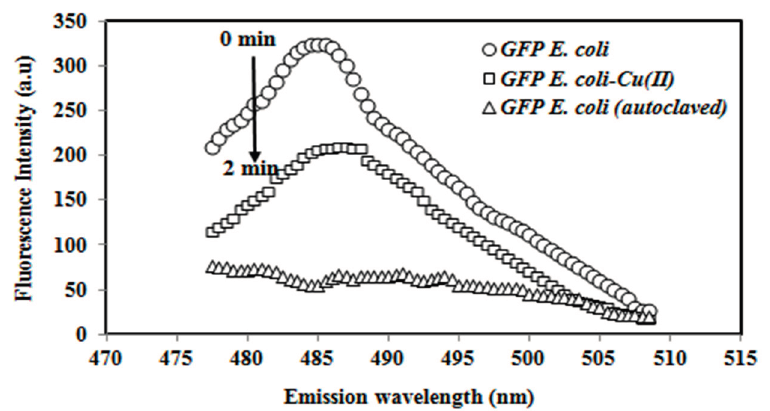
Figure 1. The emission spectra of the immobilized autoclaved green fluorescent protein (GFP) E. coli and the whole cell biosensor before and after exposure to the Cu(II) (1.0 µg/L) metal